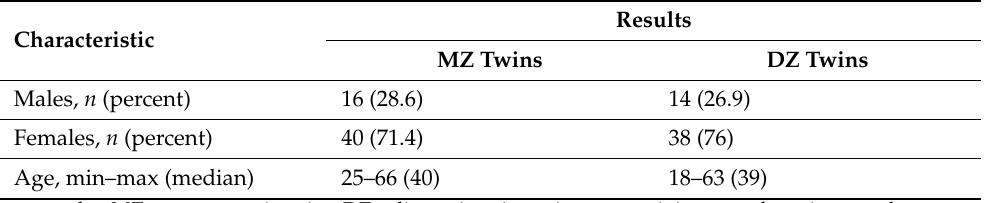
Table 1. Demographic characteristics of the study